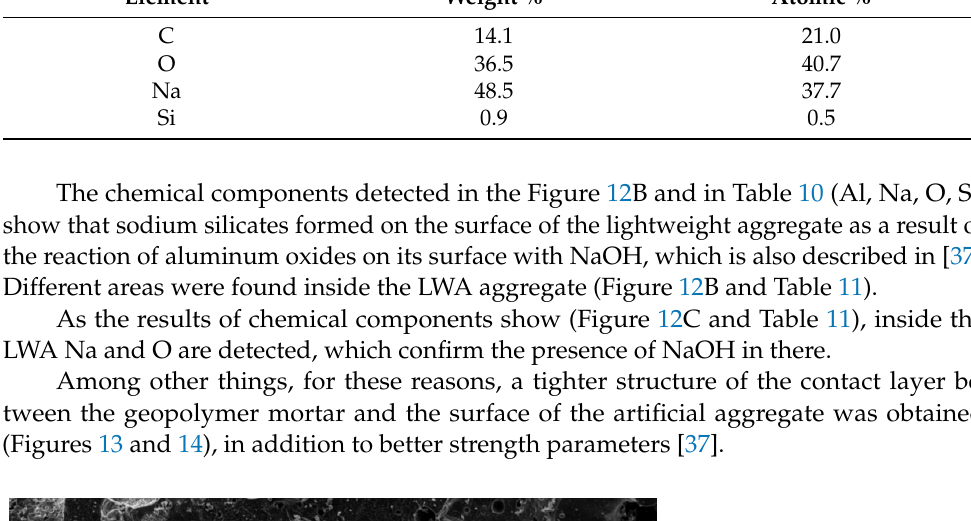
Table 11. The chemical components detected on the surface of LWA in geopolymer matrix. Element